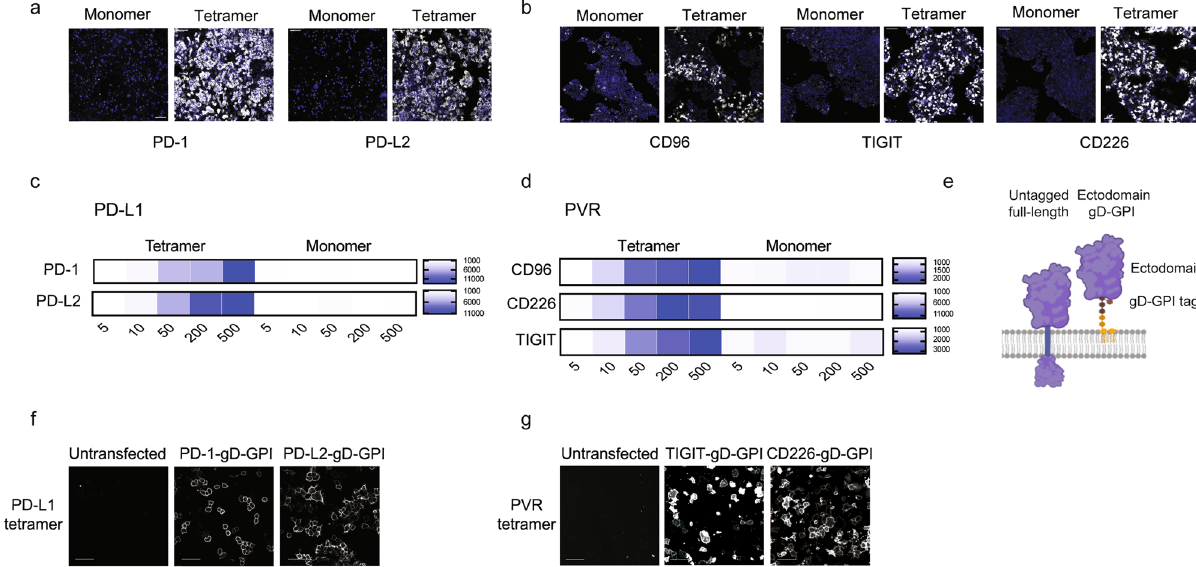
Fig. 1 Optimization of a cell-based platform for enhanced receptor-ligand discovery. Representative images of ( a ) PD-L1 or ( b ) PVR ectodomain binding to cells expressing the indicated binding partners as full-length, untagged receptors. Tetramer binding to the cell surface is represented in white, nuclei are depicted in blue. Ectodomain binding at 100 nM is shown in the representative images. Scale bar = 100 μ m. Quanti fi cation of ( c ) PD-L1 or ( d ) PVR ectodomain binding to cells expressing the indicated binding partners. PD-L1 or PVR were tested as recombinant monomeric or tetrameric ectodomains at the indicated concentrations (nanomolar) and binding to the cell surface was represented as normalized fl uorescence intensity. a Schematic representing the tagging strategy used to generate the ectodomain-gD-GPI library. Binding of ( f ) PD-L1 or ( g ) PVR ectodomain tetramer to the indicated binding partners on the cell surface, expressed as ectodomain-gD-GPI proteins. Scale bar = 50 μ